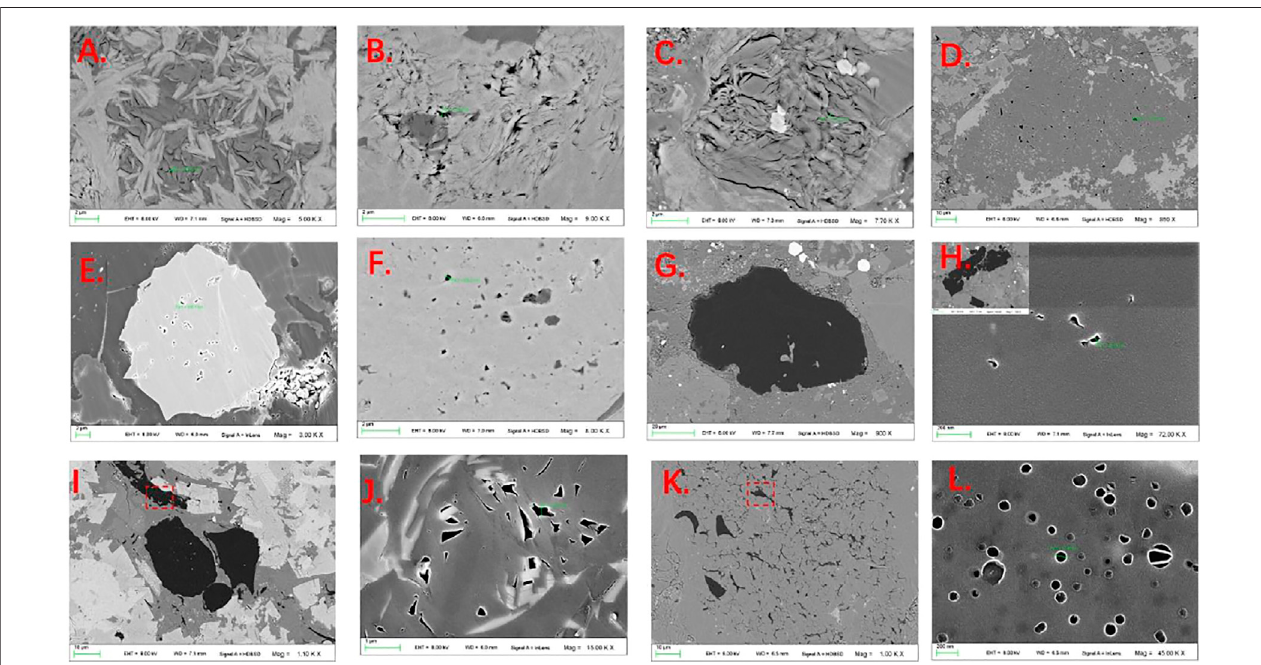
FIGURE5 | Spatial distributioncharacteristics ofmicroscopicreservoirsin different shale samplesofthe Longtan Formation. (A) The interlayerporesand fractures are developed in the lamellar smectite mixed layer and chlorite aggregates (×5000). (B) The interlayer pores and fractures are developed in the lamellar chlorite aggregates (×9000). (C) Transformed from feldspar clay minerals developed from interlayer fractures (×7700). (D) Contiguous quartz (siliceous) developed angular dissolution pores (×850). (E) Strawberry-shaped pyrite developed inter-crystalline pores (×3000). (F) Irregular dissolution pores developed in siderite (×3500). (G) Angled pores developed in organic components (×15000). (H) Arc-shaped organic matter developed circular pores (×45000). (I) Microfractures developed in fragmented organic matter (×40000). (J) Enlarged observation of interstitial organic matter in (G) ; round pores (×45000) developed inside the organic matter. (K) Concentrated distribution of fragmented and banded organic matter (×1100). (L) The enlarged observation of organic matter in (K) shows the development of angular pores (×15000).